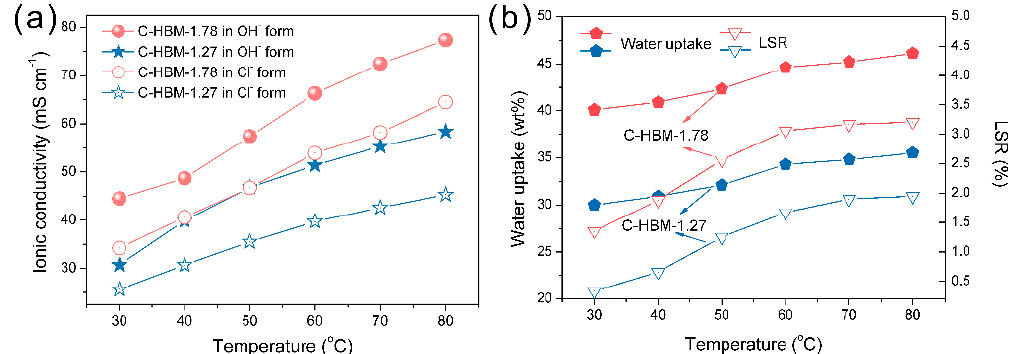
Figure 5. The ionic conductivity ( a ) and water uptake and linear swelling ratio (LSR) ( b ) as a function of temperature of membrane C-HBM-1.27 and C-HBM-1.78.